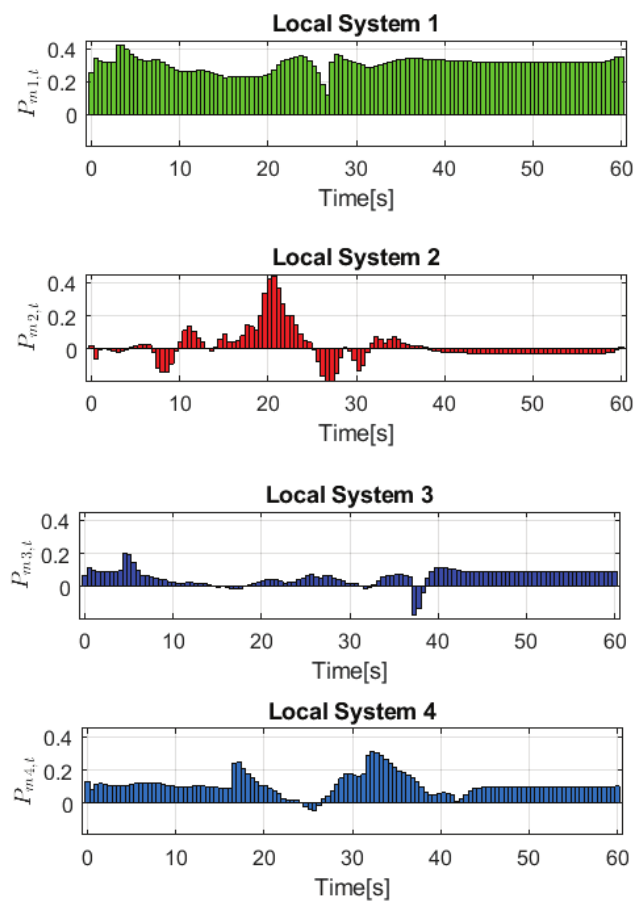
Figure 9. Optimal active power at each local system.